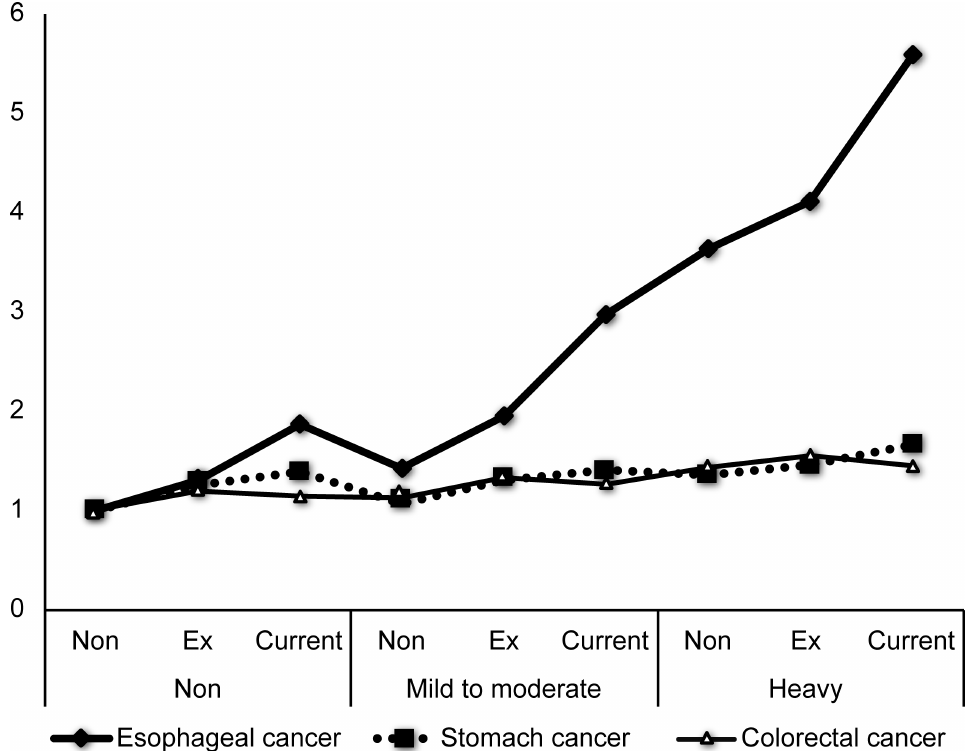
Fig 2. Esophagus, stomach and colorectalcancer risks basedon the combinedeffect of the amount of alcohol consumption and smoking status (A) Esophagealcancer, (B) Gastric cancer, (C) colorectalcancer.